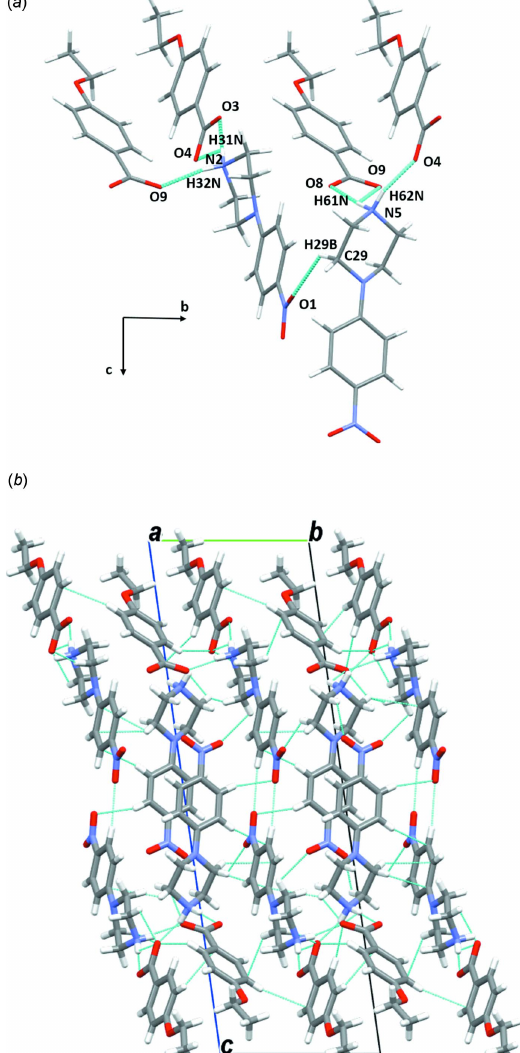
Figure 11 ( a ) A general view of the main intermolecular interactions (N—H (cid:2)(cid:2)(cid:2) O and O—H (cid:2)(cid:2)(cid:2) O) in (V) and ( b ) the molecular packing of (V) with hydrogen bonds shown as dashed